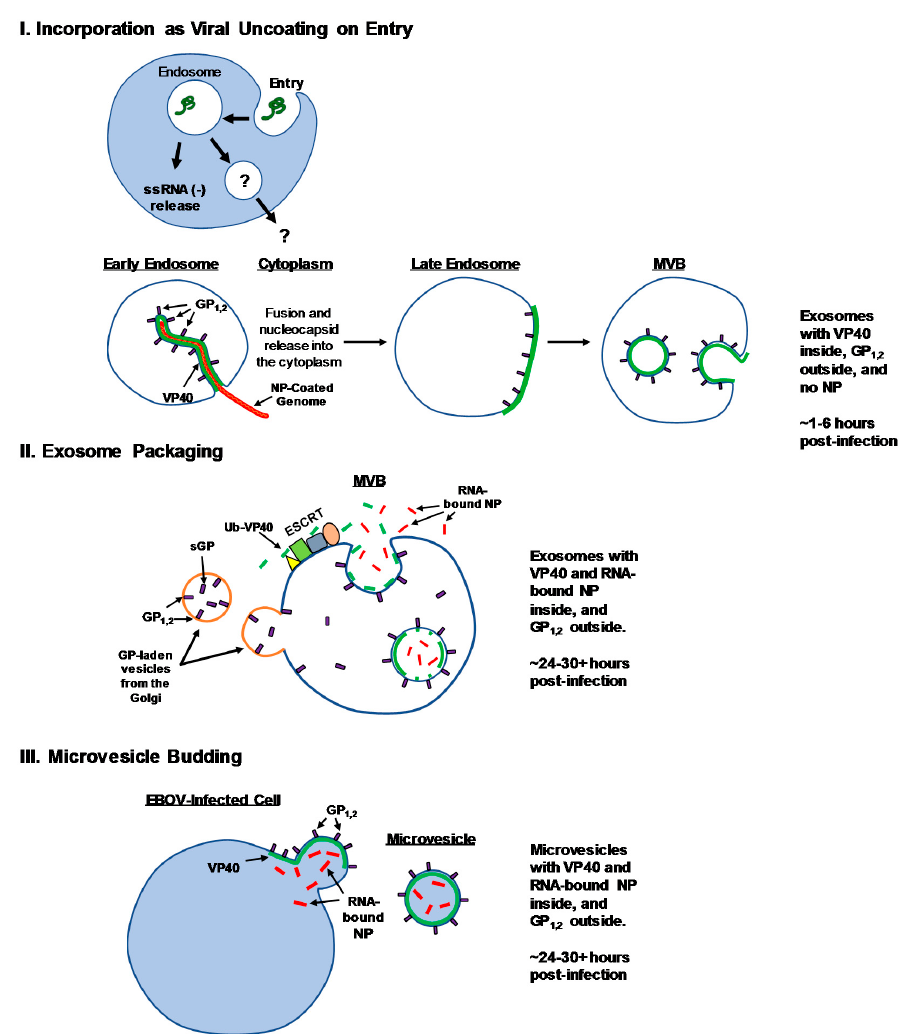
Figure 2. Possible mechanisms of unconventional EBOV protein secretion. Three proposed mechanisms of packaging of EBOV proteins VP40, GP, and NP into EVs are illustrated along with hypothesized times of release. ( I ) Incorporation as viral uncoated on entry: Entry of infectious virions or VLPs into host cells through endosomes results in cleavage of the outer portions of GP 1,2 , binding to the host receptor, and fusion with the endosomal membrane to release the viral nucleocapsid into the cytoplasm. Viral GP and VP40 proteins remaining within the endosome after nucleocapsid release may become packaged into exosomes as a result of inward budding of the endosomal membrane, resulting in extracellular release an estimated 1 – 6 h post-infection. ( II ) Exosome packaging: classical loading of cargo into exosomes through endosomal sorting complexes required for transport (ESCRT) pathway (potentially ubiquitinated VP40; Ub-VP40), Golgi vesicle transport (GP 1,2 and soluble GP (sGP)), and other mechanisms (NP). Resulting hypothesized exosomes would be released approximately 24 – 30+ h post-infection (after viral translation of new protein components), and contain GP 1,2 on the surface, and VP40 and NP on the inside. The secretion of free sGP may also take place through fusion of multivesicular bodies (MVBs) with the plasma membrane. ( III ) Microvesicle budding: The outward blebbing of microvesicles from the plasma membrane containing nontraditionally assembled EBOV components. GP 1,2 is estimated to be oriented on the surface, with VP40 and NP on the inside. Microvesicles are estimated to be released approximately 24–30 + h post-infection. Additional details of these models are discussed in the